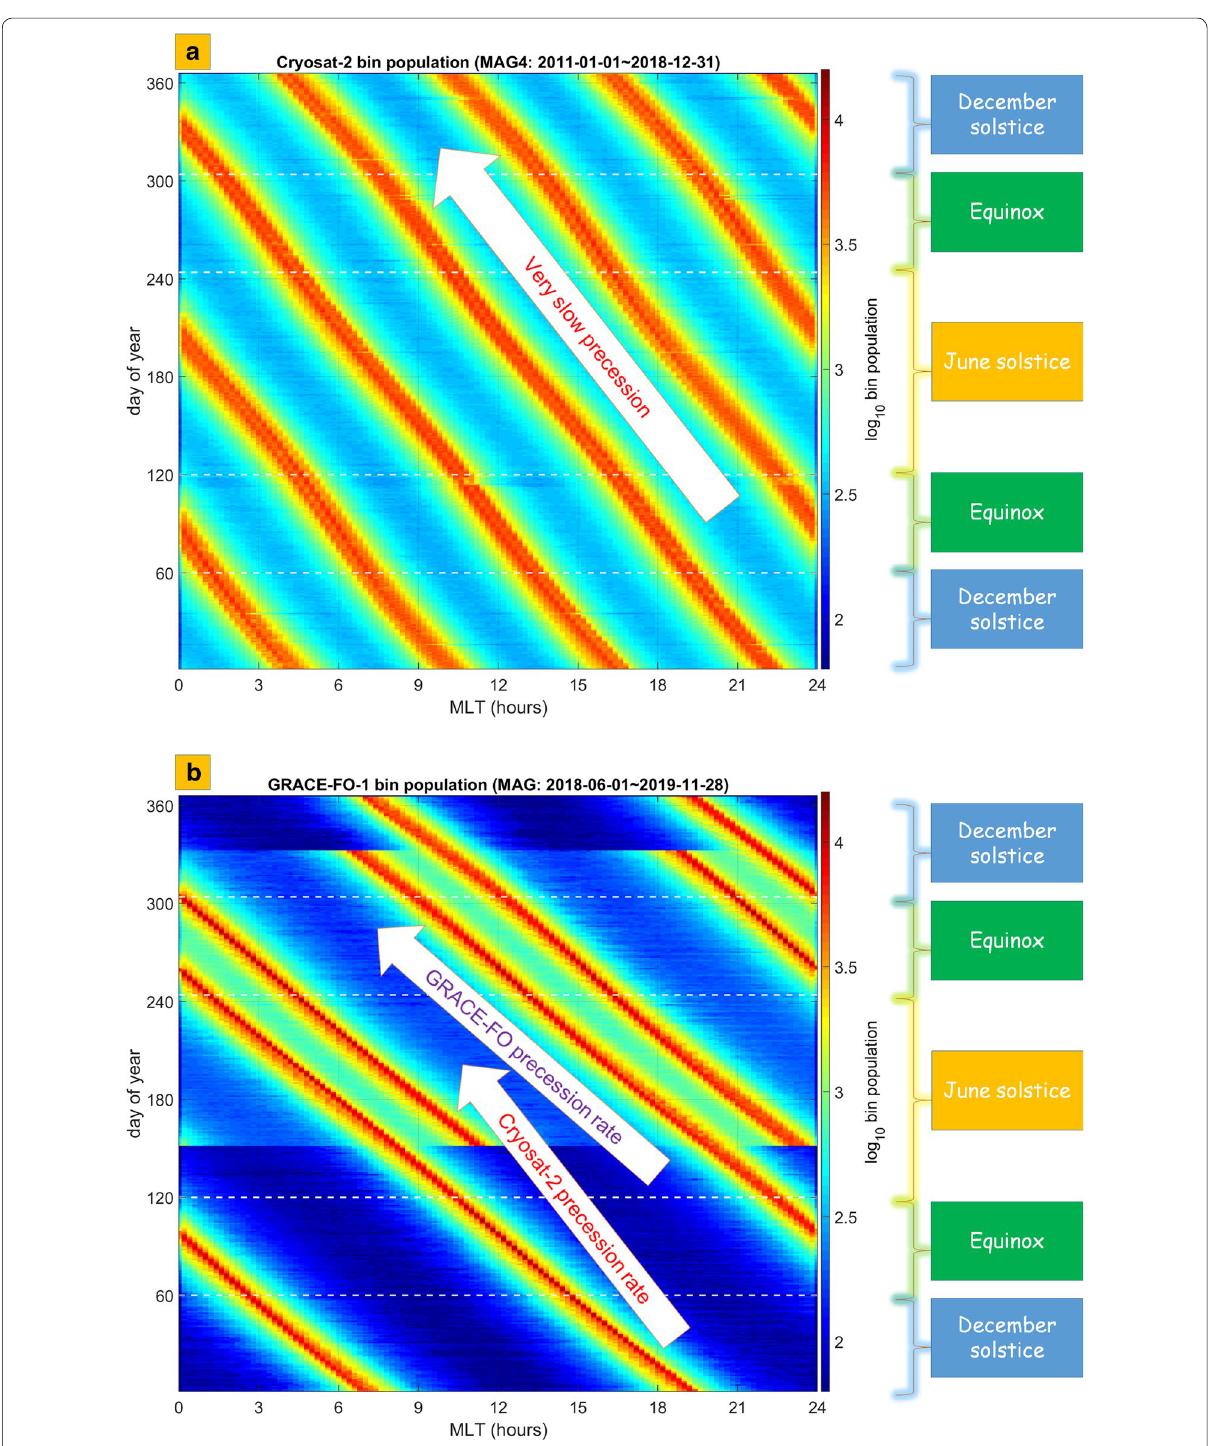
Fig. 1 Data coverage as a function of MLT and day-of-year for a CryoSat-2 and b GRACE-FO. Borders for different seasons are given as annotations on the right-hand side. The ‘MAG4 ′ in the title of the top panel signifies a combined solution of B-field from the three magnetometers onboard